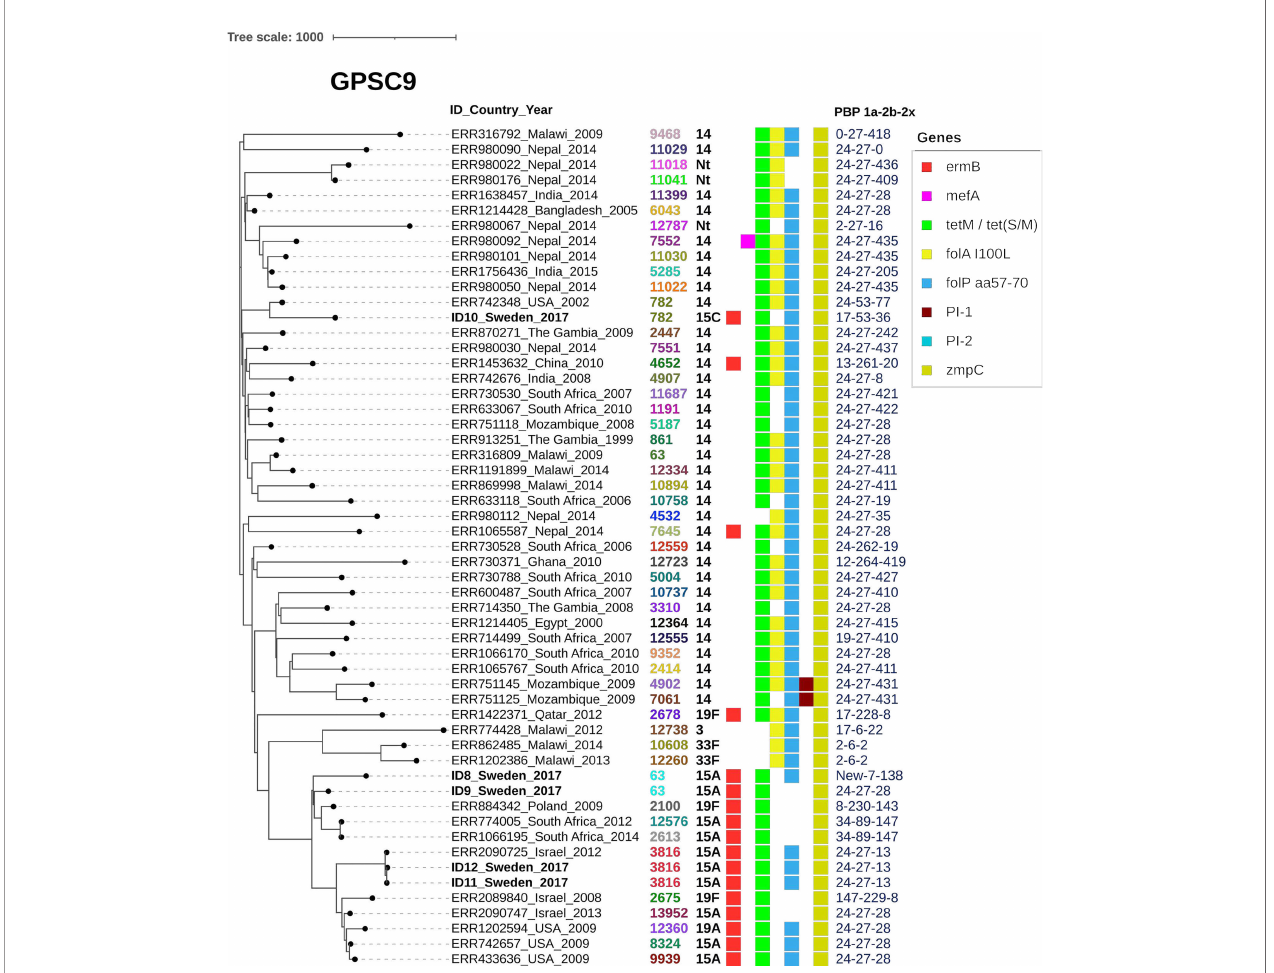
FIGURE 2 | Zinc metalloproteinase C is highly preserved among isolates belonging to GPSC9. GPSC9 tree including 55 isolates showing ID number, Country and Year followed by serotype, MLST, gene presence and PBP-pro fi le (1a-2b-2x). As a reference isolate ID 9 was used. All the Swedish isolates and all the included 100% harbor the gene for zinc metalloproteinase C ( zmpC ). Macrolide resistance gene ermB was mostly present in a subclade with serotype 19A, 19F and 15A isolates. Most of the Swedish isolates (4/5), belonged to this subclade with one exception being the ST782 serotype 15C isolate more closely related to other pneumococci within GPSC9. This 15C isolate diverged in both serotype and PBP pro fi le from other closely related pneumococci. Regarding the PBP pro fi le PBP-1a allele 24 is common within the GPSC among our included isolates. Only two isolates carried Pilus islet 1 (PI-1) that are closely related from Mozambique. Pilus islet-2 was not found among either of the isolates